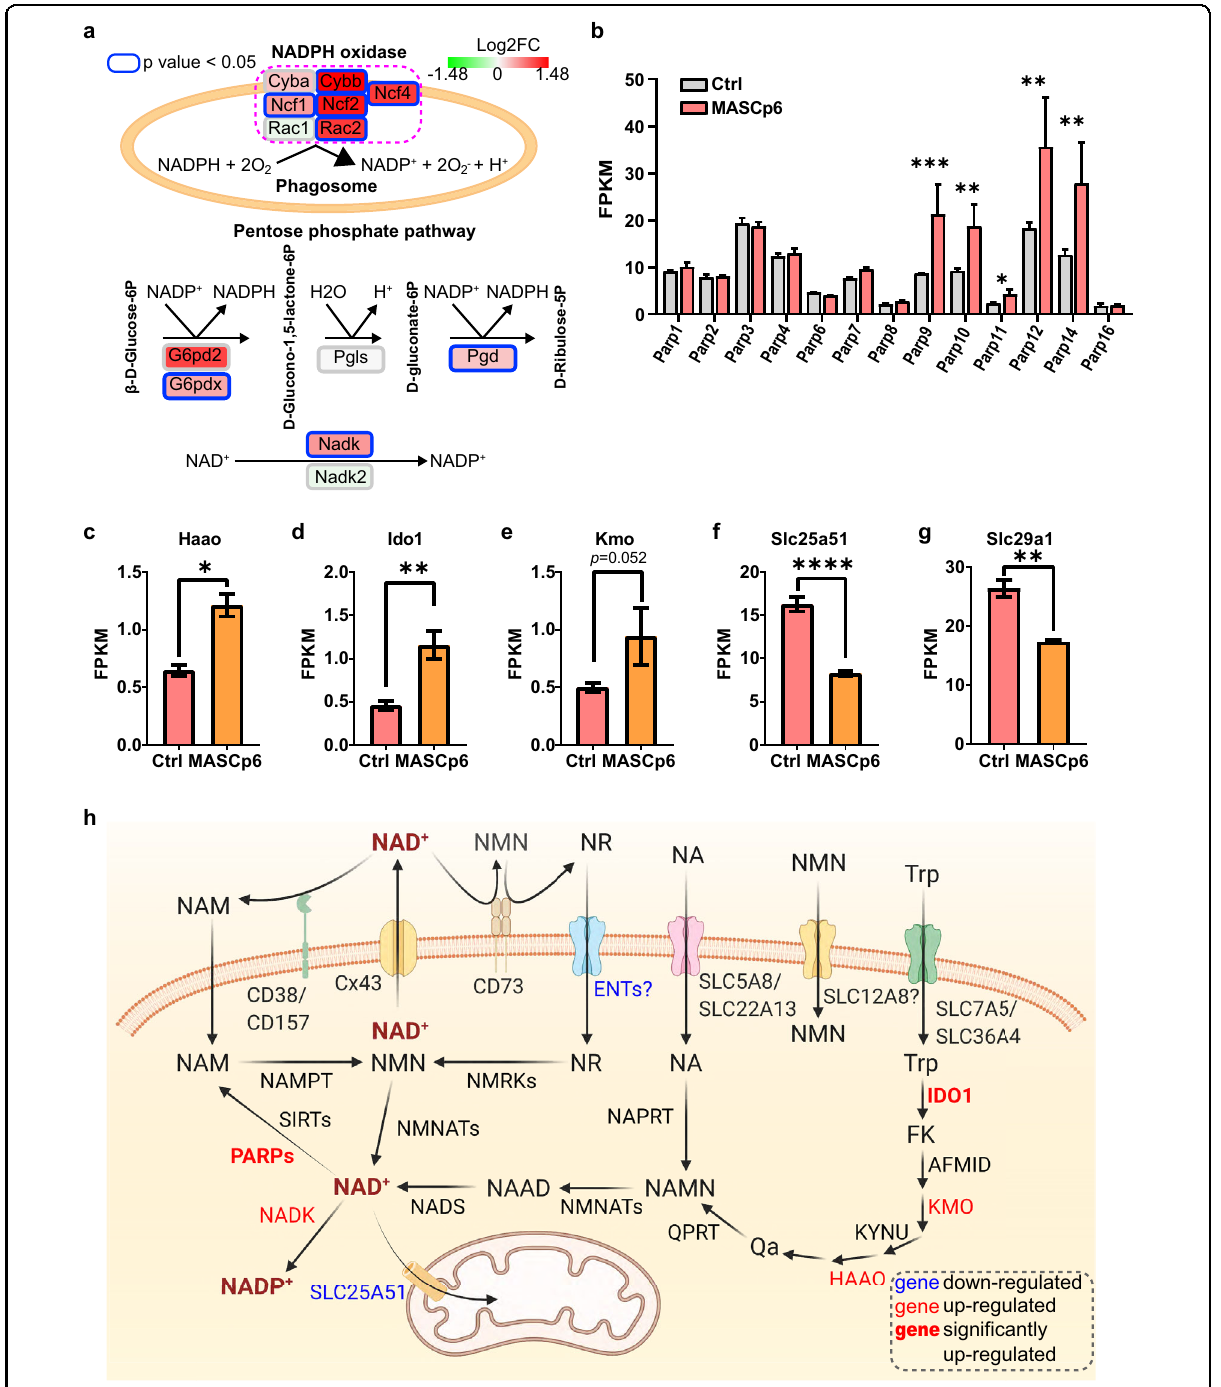
Fig. 3 MASCp6 infection leads dysregulation of NAD(H) and NADP(H) related genes. a Schematic diagram of NADPH oxidase complex and oxidative phase of pentose phosphate pathway. The fi ll color of gene represents relative expression level in lungs of MASCp6-infected and control mice. b Bar plot shows relative expression levels of PARPs. c – g Bar plots show relative expression levels of three NAD + de novo synthesis-related genes, Haao ( c ), Ido1 ( d ), and Kmo ( e ), and two nucleoside transporter genes, Slc25a51 ( f ) and Slc29a1 ( g ). h Schematic diagram (created in BioRender. com) of NAD + metabolism pathway (referred to ref. 3 ). Downregulated: P < 0.05 and FC < 1; upregulated: P < 0.05 and FC > 1; signi fi cantly upregulated: P < 0.05 and FC > 2. NA, nicotinic acid; NAMN, nicotinic acid mononucleotide; NAAD, nicotinic acid adenine dinucleotide; NR, nicotinamide riboside; NAM, nicotinamide; NMN, nicotinamide mononuclotide; Trp, tryptophan; FK, formyl-kynurenine; Qa, quinolinate. All gene expression data are from RNA-seq. All data are shown as means ± SEM. * P < 0.05, ** P < 0.01, *** P < 0.001, **** P <